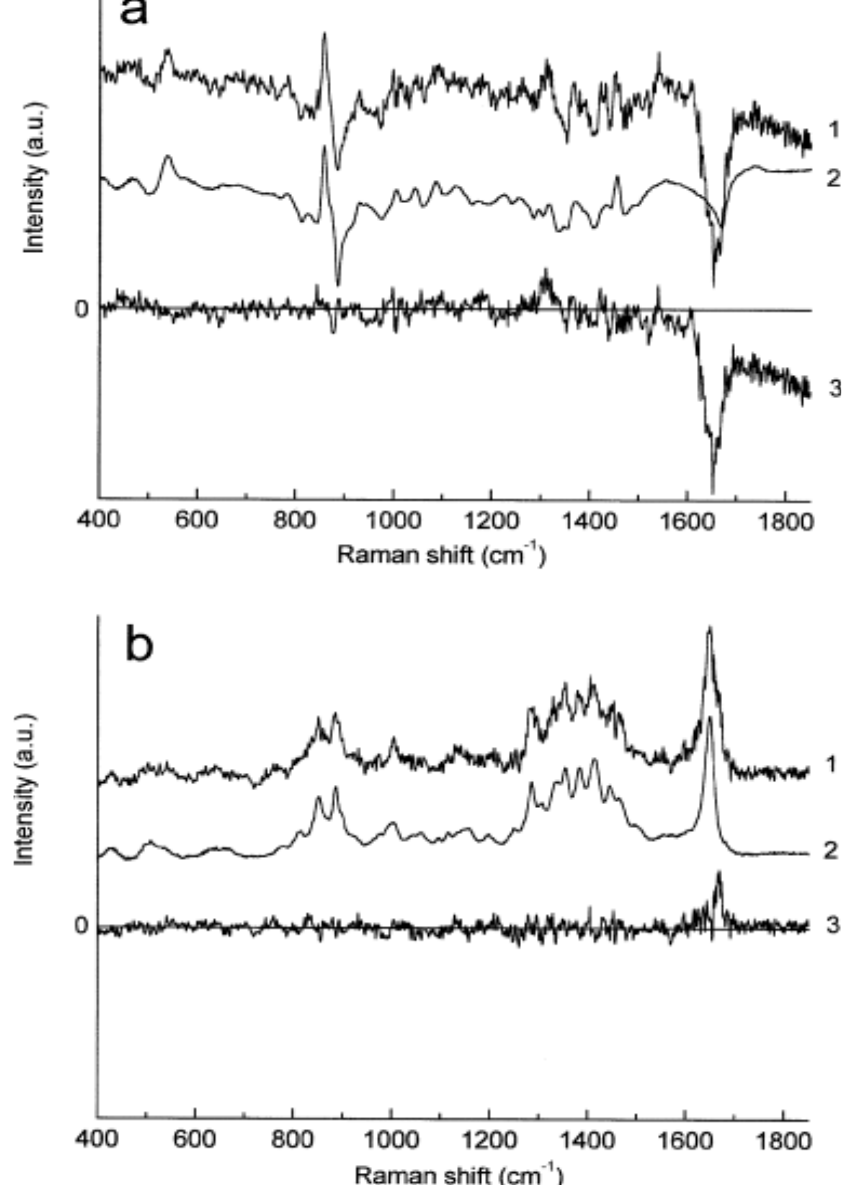
Figure 5. Raman spectra obtained at different depths below the skin surface by means of the qualitative least-squares fit. ( a ) (1) Difference between Raman spectra obtained at the skin surface and at 10 µ m below; (2) fit result; (3) residual (curve 1–curve 2). ( b ) (1) Difference between Raman spectra obtained at 60 µ m and 70 µ m below skin surface; (2) fit result; (3) residual (curve 1–curve 2)